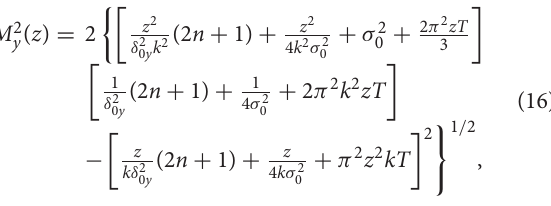
z plane with, ρ y 0, − =